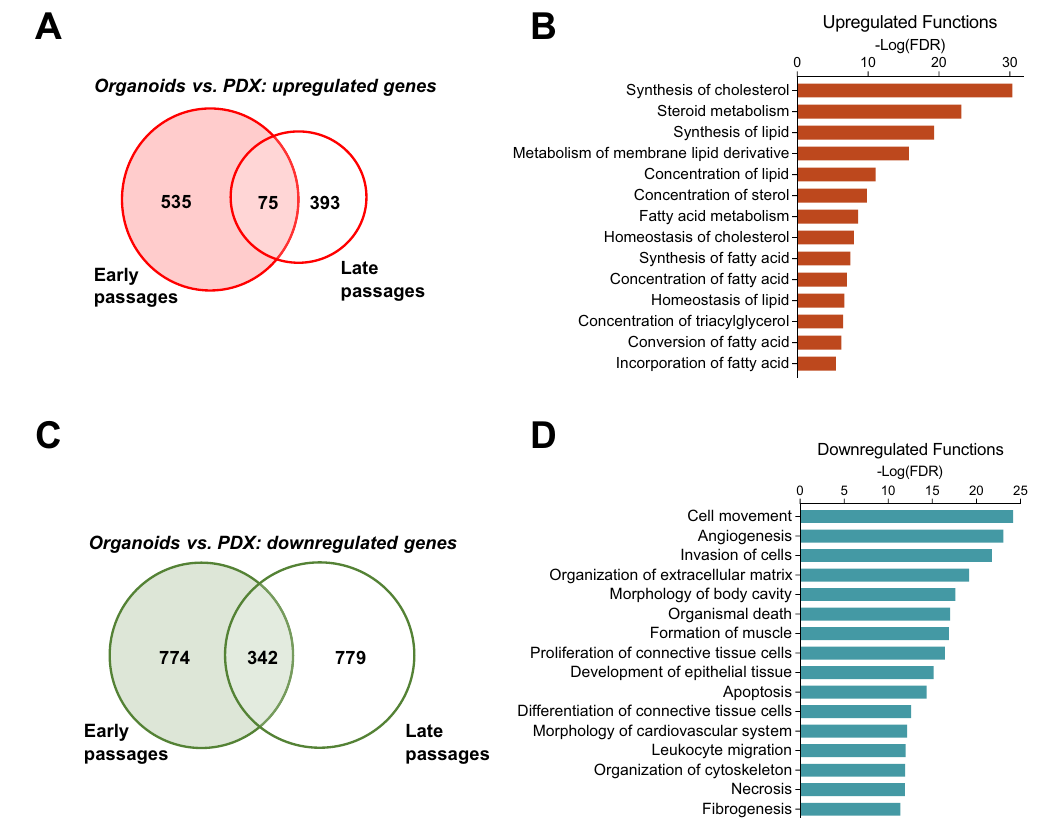
Figure 5. Transcriptional changes between PDX and organoids models reflect differences in cell composition. ( A ) Upregulated genes in organoids vs. PDX in early and late passages. ( B ) Ingenuity pathway analysis of genes upregulated in organoids reveals enrichment of lipid synthesis and metabolism genes. ( C ) Downregulated genes in organoids vs. PDX in early and late passages. ( D ) Ingenuity pathway analysis of genes downregulated in organoids reveals enrichment of extracellular matrix